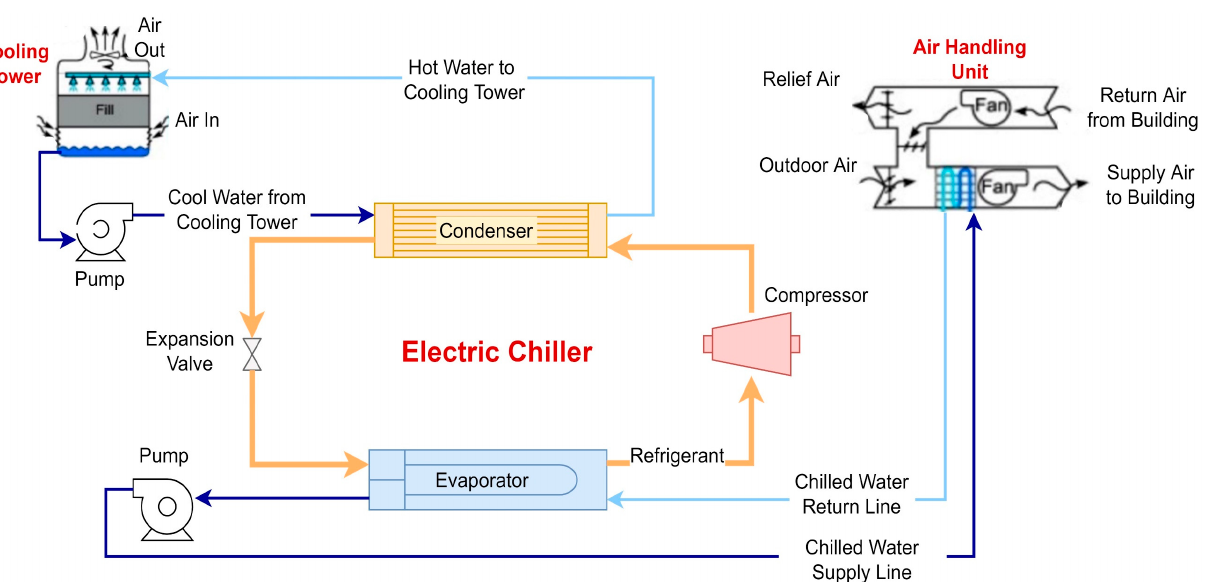
Figure 2. Schematic of Chiller